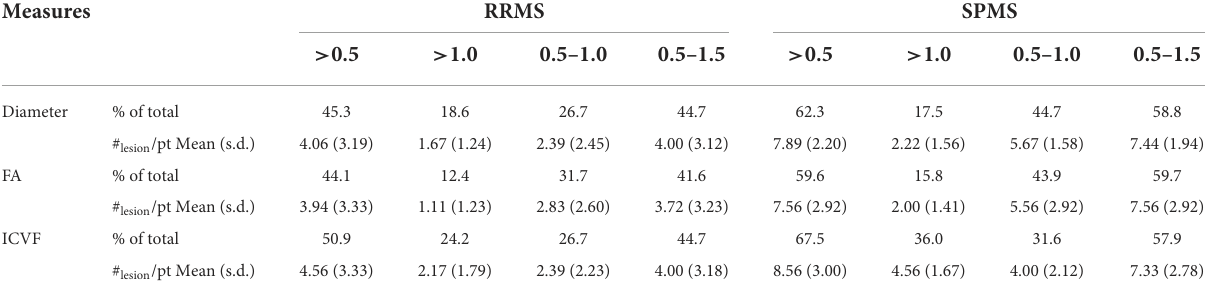
TABLE 2 The percentage and number of chronic active lesions in each cohort based on z-score definitions.